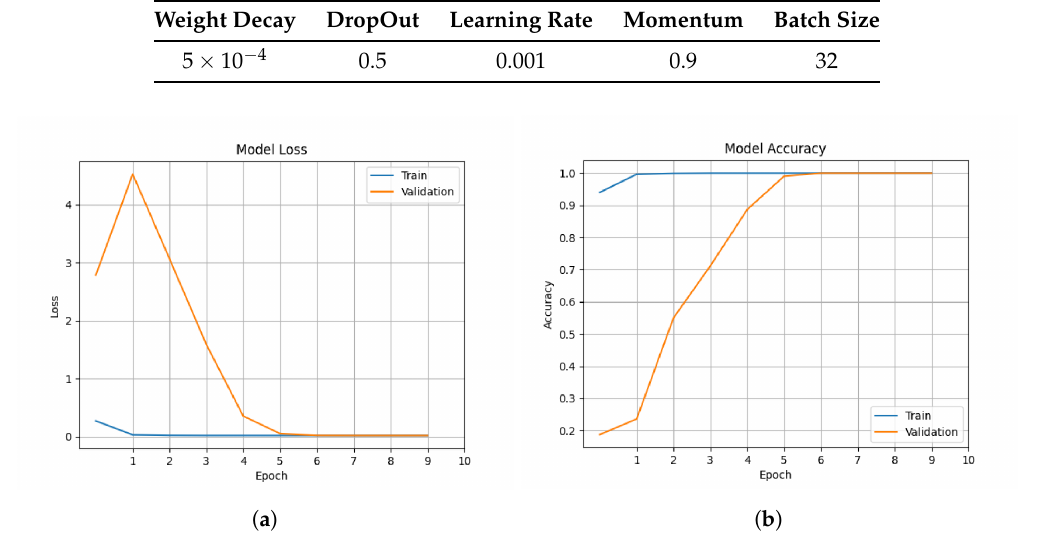
Figure 11. Curves of ( a ) average loss and ( b ) average accuracy during the model training for fruit classification.